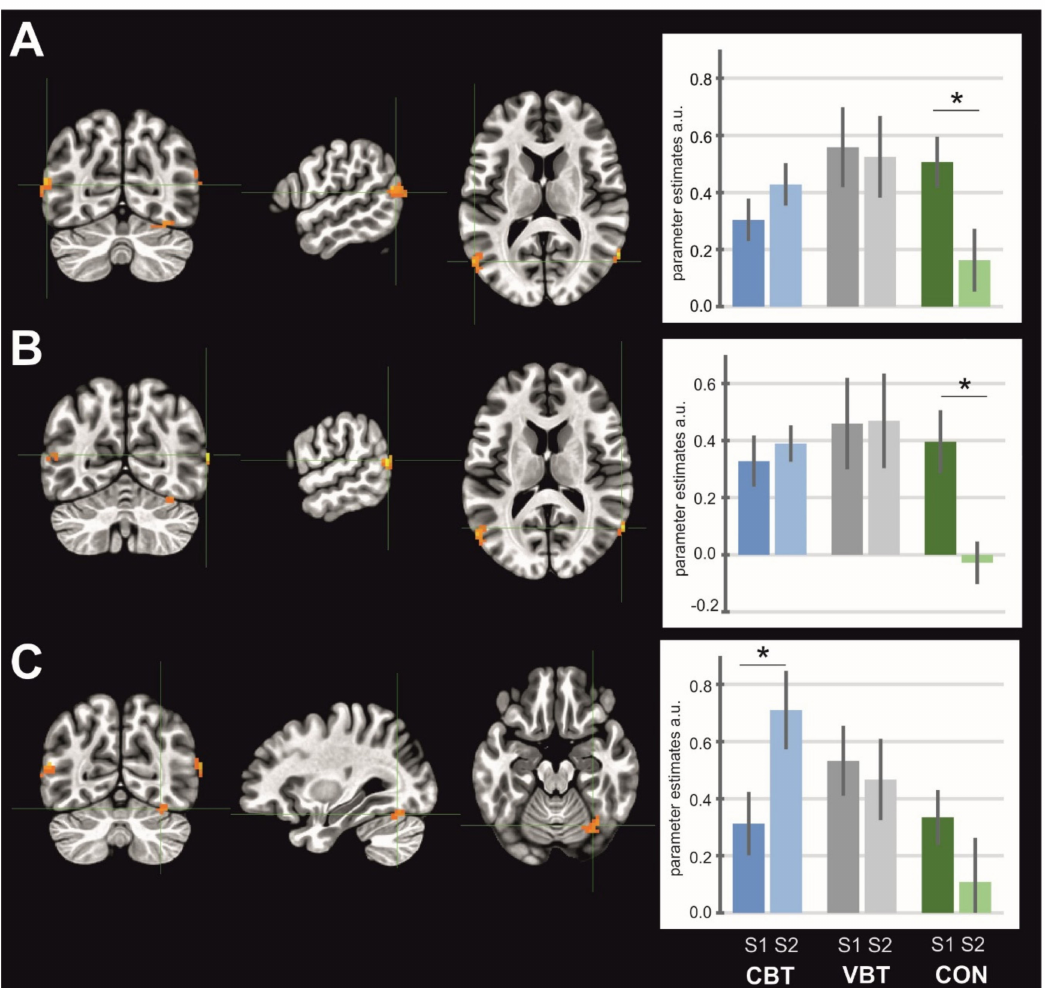
Figure 5. Brain structures showing interaction between groups and sessions for AOMI task; ( A ) left middle occipital gyrus (laterally) / area V5, ( B ) right middle occipital gyrus (laterally) / area V5, ( C ) cerebellum–inferior semilunar lobule / tonsil. Note: CBT—classical balance training, VBT—virtual reality balance training, CON—control group; asterisk indicates significant di ff erences between sessions.